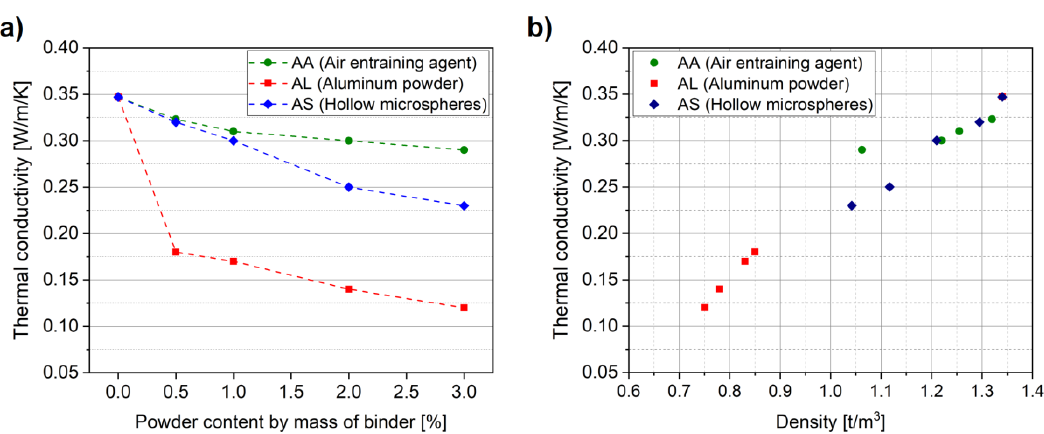
Figure 6. Thermal conductivity of the specimens with different additives: ( a ) thermal conductivity vs. powder content; ( b ) thermal conductivity vs. density.